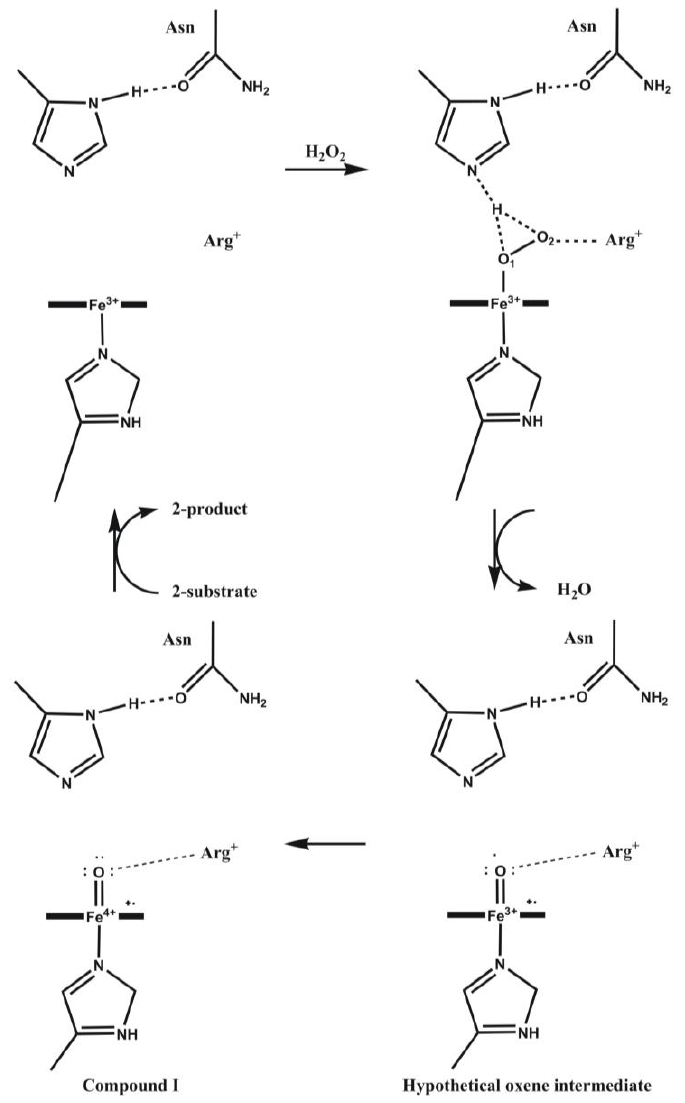
Figure 10. Catalytic mechanism of the formation of Compound I. The distal His assists in removing a proton from the incoming peroxide and delivering it to the peroxide O